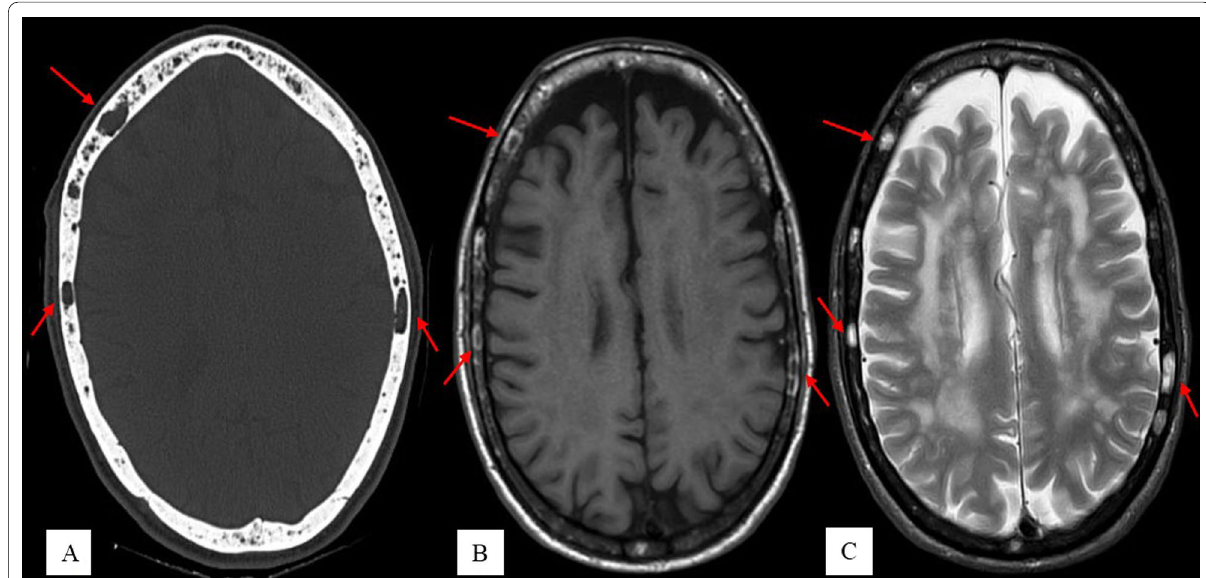
Fig. 1 Detection of number of lesions by CT and MRI in a 72 year old male known case of multiple myeloma ( A ) CT bone algorithm image shows multiple ill defined lytic lesions within the diploic space. MRI T1W ( B ) and T2W ( C ) images at the same level show multiple lesions appearing hypointense on T1W and hyperintense on T2W image. Both CT and MRI were able to depict multiple lesions in skull